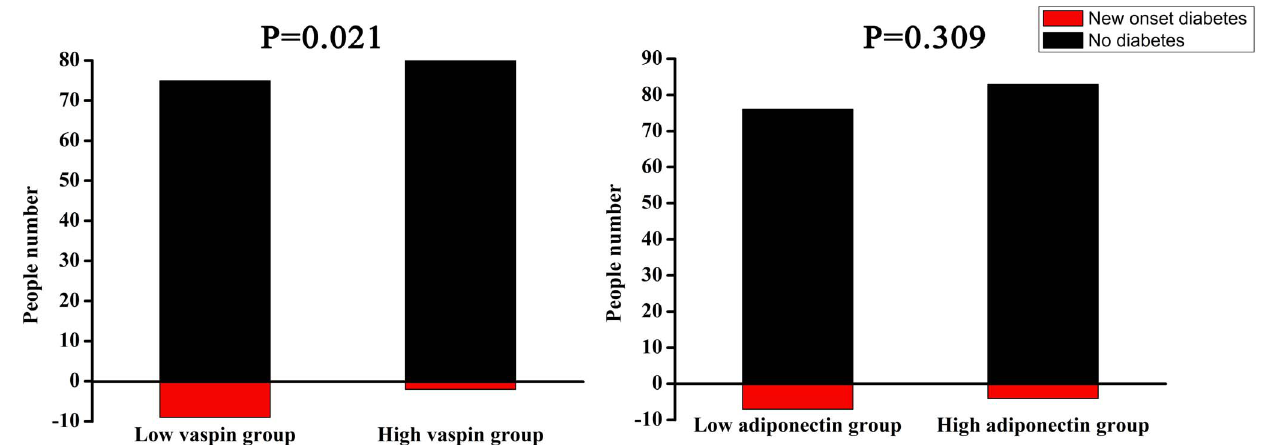
Figure 1. Percentages of new occurrences of T2DM in control subjects with low or high vaspin and adiponectin levels at follow-up. Red and black bars represent new onset diabetic patients and non-diabetic subjects in control group at follow-up, respectively. x 2 test was used to analyze the difference of percentage of new onset diabetic patients in sub-groups with low and high vaspin levels.